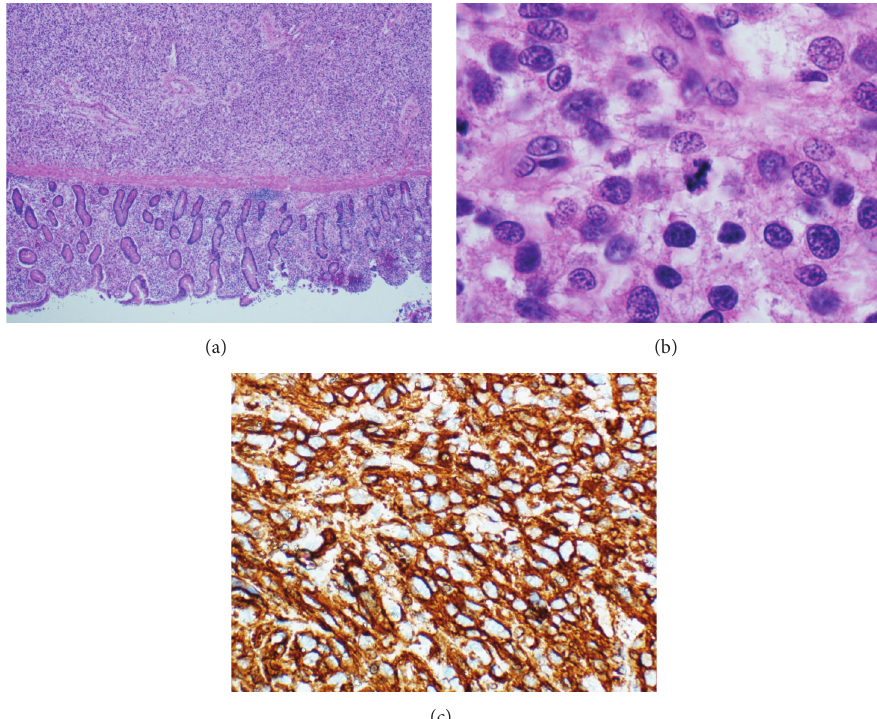
Figure 3: (a) Hematoxylin and Eosin staining ( × 40) (b) ( × 100) of the tumor at the submucosa and muscular layer of the small bowel and showing (c) immunopositivity for SMA.